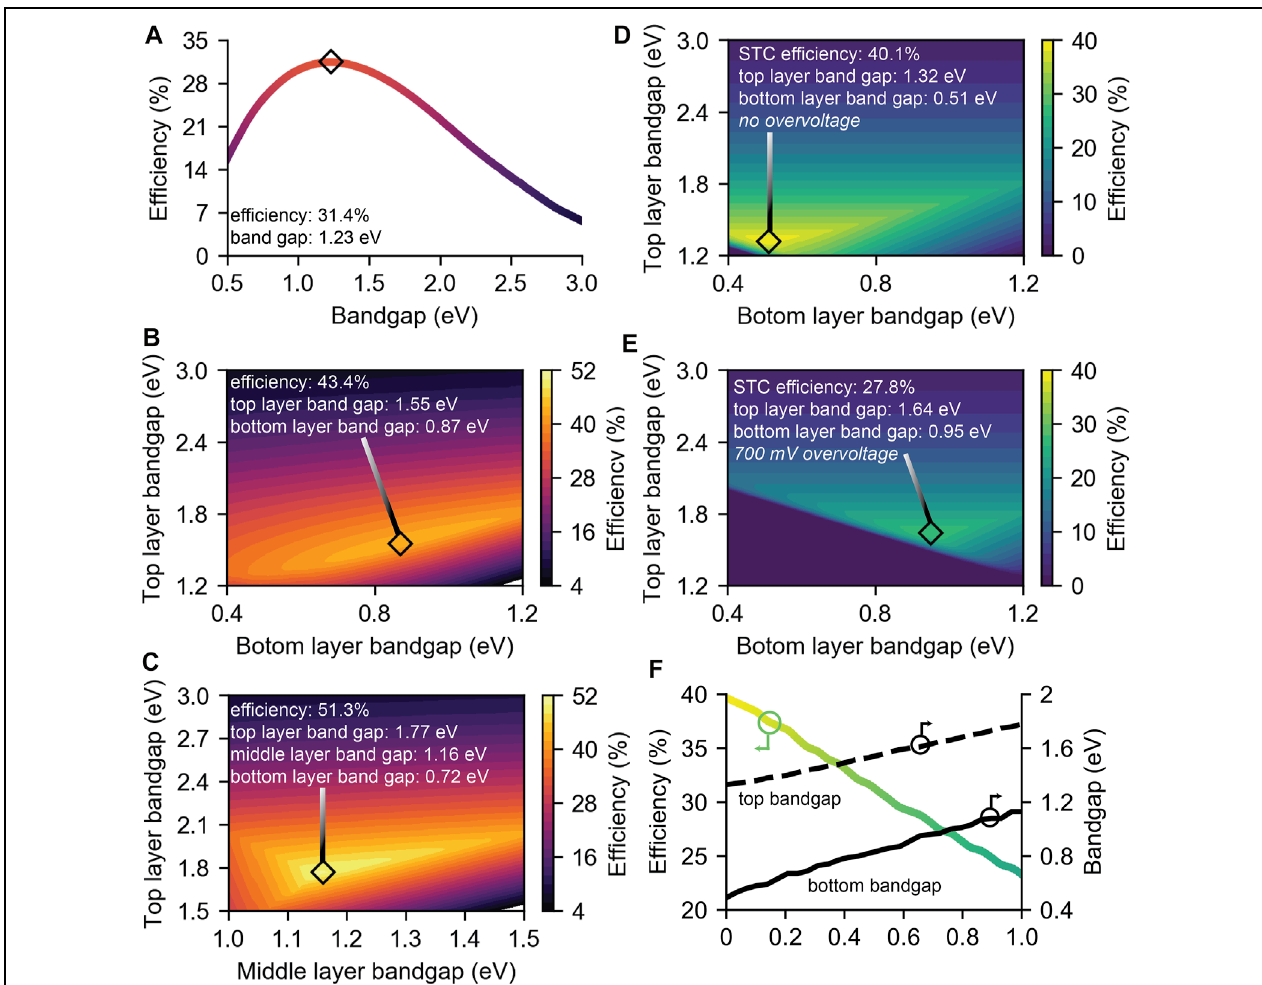
FIGURE 2 | Theoretical efficiencies of PV and PEC devices. Detailed-balance efficiency limits as a function of bandgap energies for (A) single-junction, (B) two-junction, (C) three-junction photovoltaic devices. (D and E) Solar-to-chemical (STC) efficiency for two-junction water splitting PEC devices producing molecular hydrogen with 0 mV (D) and 700 mV (E) overvoltage. (F) STC efficiency and optimal bandgaps for two-junction H 2 -generating PEC devices as a function of overvoltage. Coloring in (A) and (F) correspond to contour coloring in (B,C) and (D,E) respectively. Average flux at solar noon at Jezero Crater is used as the reference solar